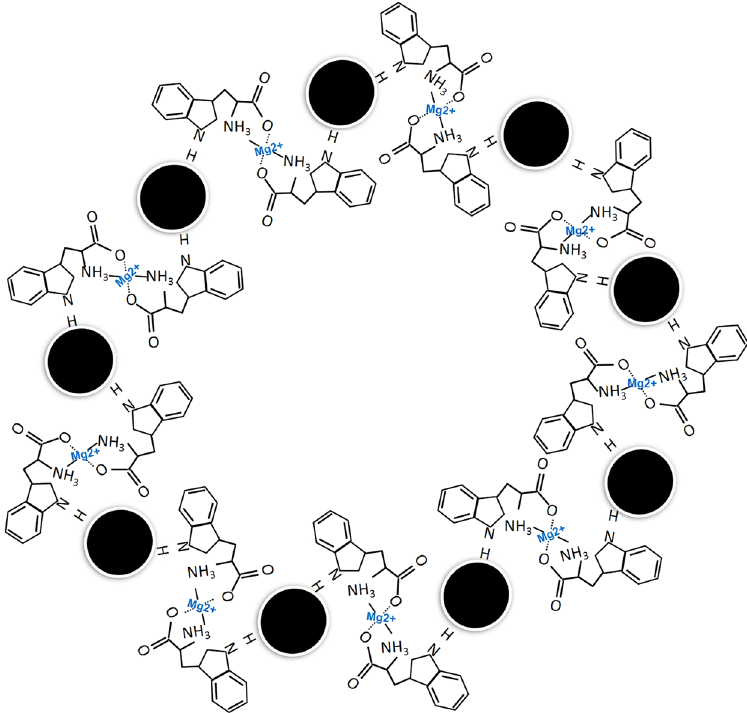
Figure 1. Proposed coordination mechanism of Mg 2 + with tryptophan